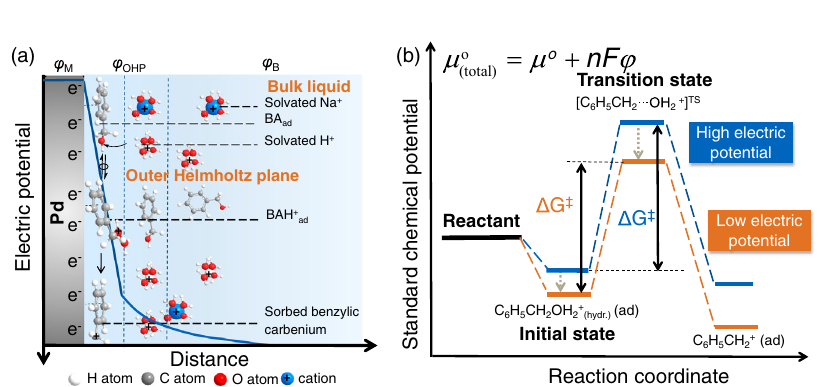
Fig. 5 | Schematic illustration of the rate-determining step and the energy diagram. a The Reaction steps of benzyl alcohol hydrogenolysis between Pd sur- faceandHelmholtzplaneandthepotentialpro fi leasafunctionofdistancefromPd